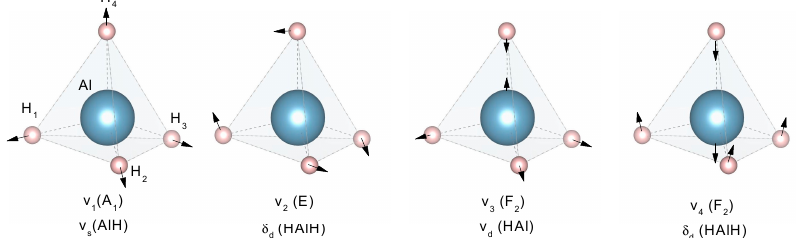
Figure 27. Normal modes of vibration of tetrahedral [AlH 4 ] − . Adapted from reference [302].